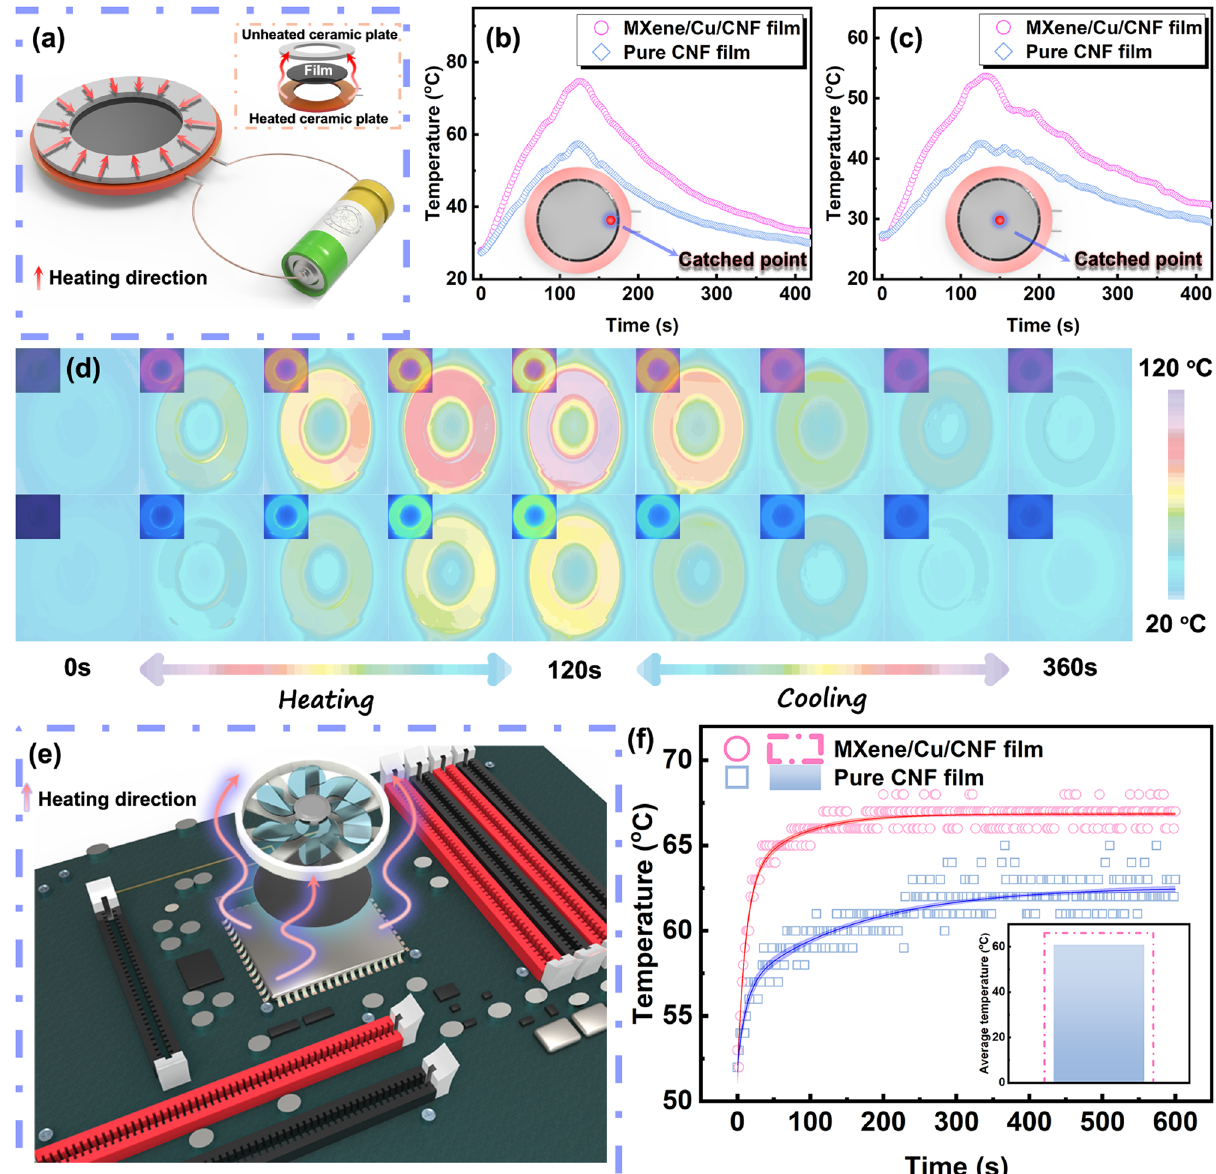
Figure 5: ( a ) Mechanism diagram of the heated device. The time - temperature curve of ( b ) margin and ( c ) center points captured from the ( d ) corresponding temperature contour - line images of the MXene/Cu/CNF fi lms with copper powders in 1 μ m diameter and pure CNF fi lm. The temperature contour - line images were drawn by the temperature date of the inset infrared images photographed by an infrared camera. ( e ) Mechanism diagram of a cooling radiator and ( f ) corresponding time - temperature curves of